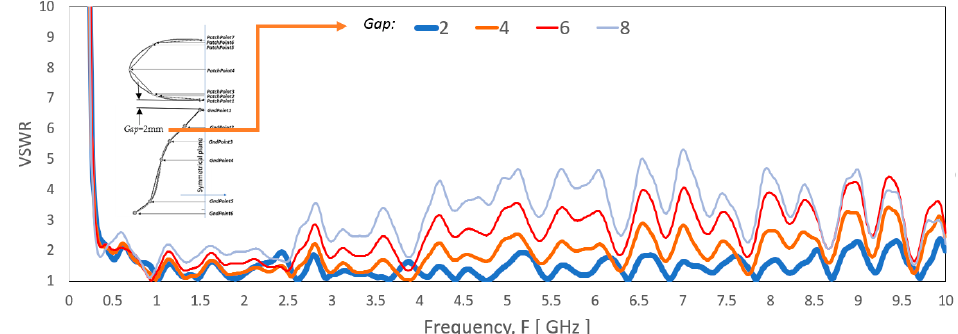
Figure 20. VSWR of the antenna with a few different gap, Gap between the elliptical-liked shape radiating element and the bell-liked shape ground plane.